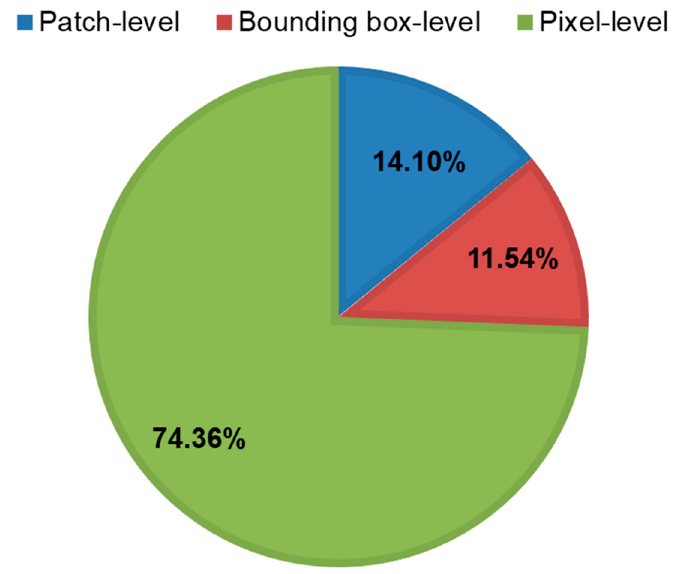
Figure 15. Distribution of used artificial intelligence models in CBD_NDT.